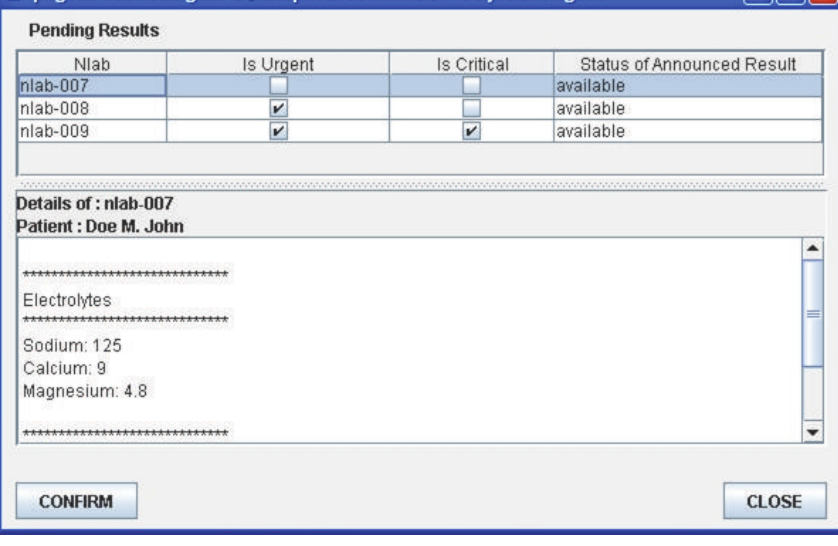
Figure 4: Tuan’s physician agent GUI.